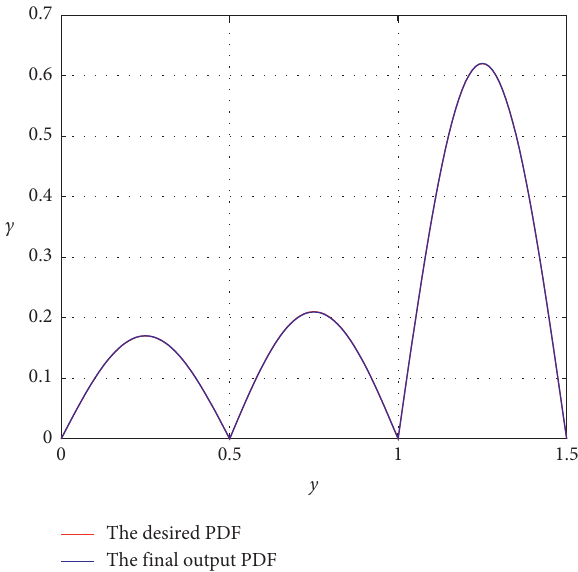
Figure 7: The expected output PDF and the final output PDF with the proposed FTTC